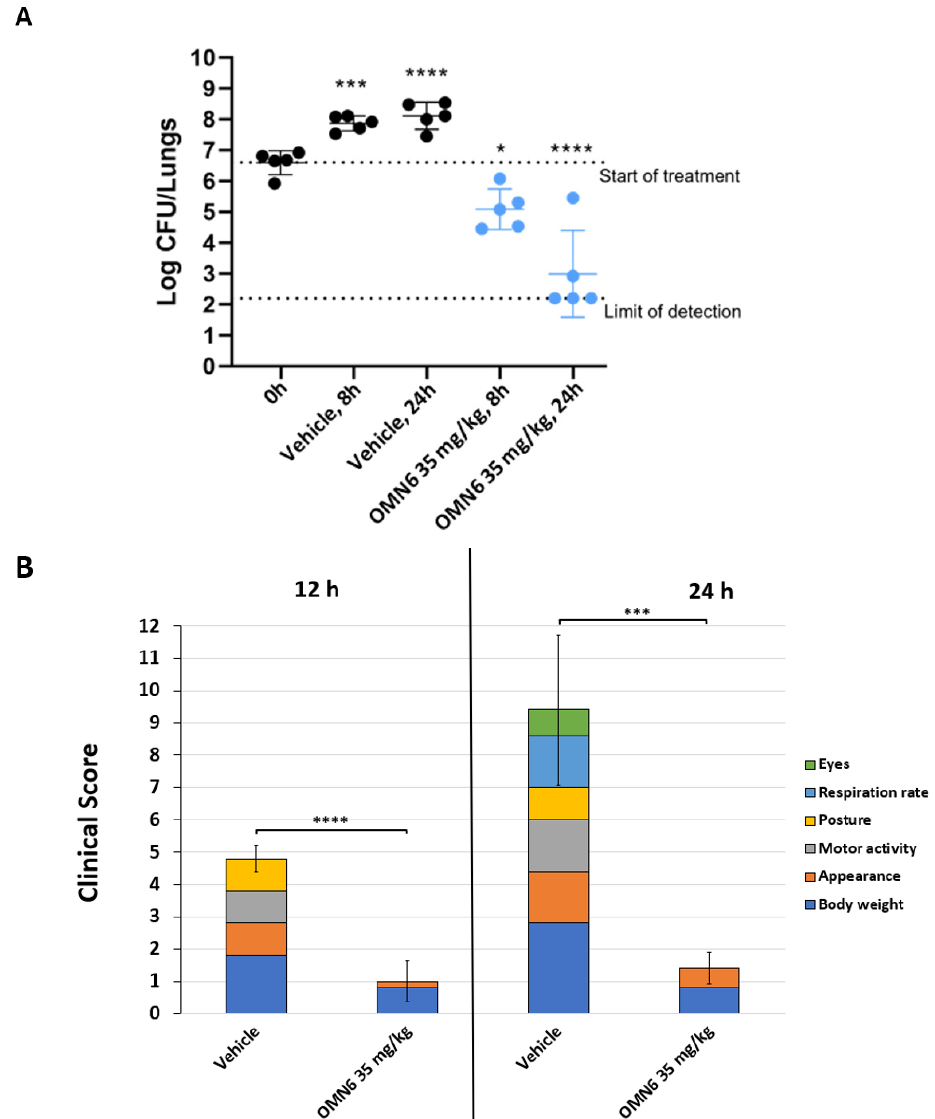
Figure 4. Time-course efficacy of OMN6 in a mouse lung infection model induced by an MDR AB clinical isolate. ( A ) Lung bacterial burden. Neutropenic CD-1 male mice were intratracheally inoculated with an MDR AB ACC000535 clinical isolate (2.7 × 10 6 CFU/lungs). OMN6 at a dose of 35 mg/kg, or 0.9% Normal Saline solution (Vehicle), was administered by three intravenous bolus injections, one injection per hour (timepoints T0h, T1h, T2h), starting from 2 h post-infection (timepoint T0h). The bacterial burden was determined at 8 h (T8h) and 24 h (T24h) post-start of treatment. Statistical analysis was performed by using one-way ANOVA followed by Dunnett’s post hoc test ( n = 5, p values vs. T0h, * p < 0.05, *** p < 0.001, **** p < 0.0001). ( B ) Clinical score. Six criteria (body weight, appearance, motor activity, posture, respiration rate, and eyes) were assessed to provide an overall clinical score of 0 to 21 (*** p < 0.001, **** p < 0.0001; according to